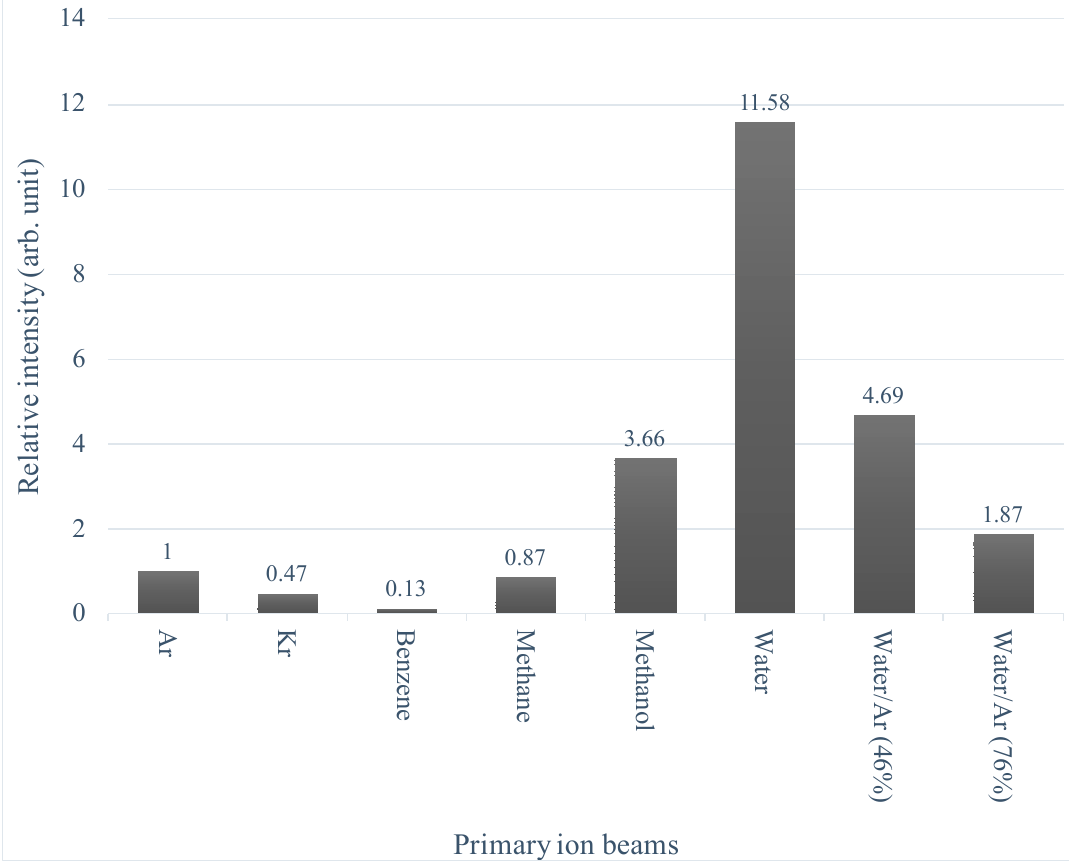
Figure 7. Relative intensities of molecular ion for aspartic acid ([M+H] + , m/z = 134 ) obtained with Ar 1500+ , Kr 1500+ , benzene (C 6 H 6 ) 1500+ , methane (CH 4 ) 1500+ , methanol (CH 3 OH) 1500+ , water (H 2 O) 1500+ , and water (H 2 O)/Ar mixed clusters primary ion beams. The acceleration voltage of the clusters is 5 kV. The selective mass of the mixed cluster is 27,000 Da, which is the same as the (H 2 O) 1500+ cluster at m / z . Each intensity is normalized by the intensity for the Ar cluster irradiation.